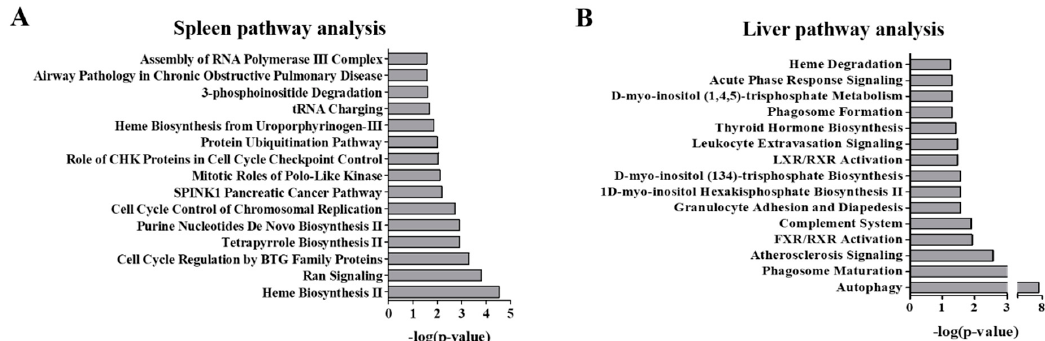
Figure 2. Pathway analysis of the differential proteome of the spleen and liver of 11-week Npc1 − / − mice. Differential proteins from the mass spectrometry analysis of the spleen ( A ) and liver ( B ) of Npc1 − / − mice were enriched for the top 15 pathways. Significance was determined using a Right-tailed Fisher’s exact test to determine probability of pathways from the Ingenuity Pathway Analysis Knowledge Base Library to those most significantly enriched.